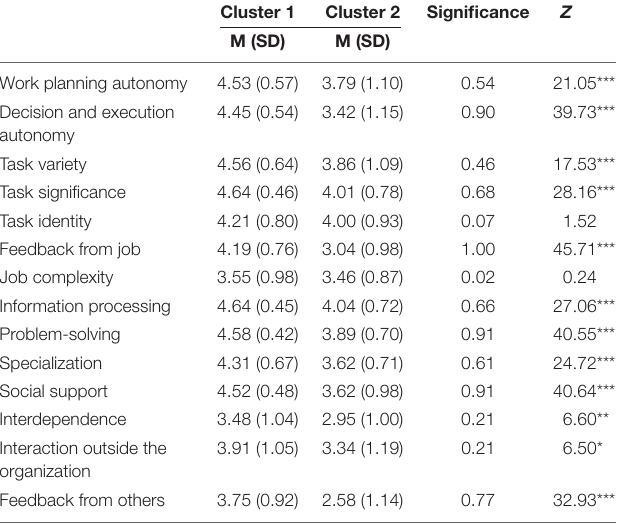
TABLE 2 | Descriptive and differences between Cluster 1 ( N = 71) and Cluster 2 ( N = 37).